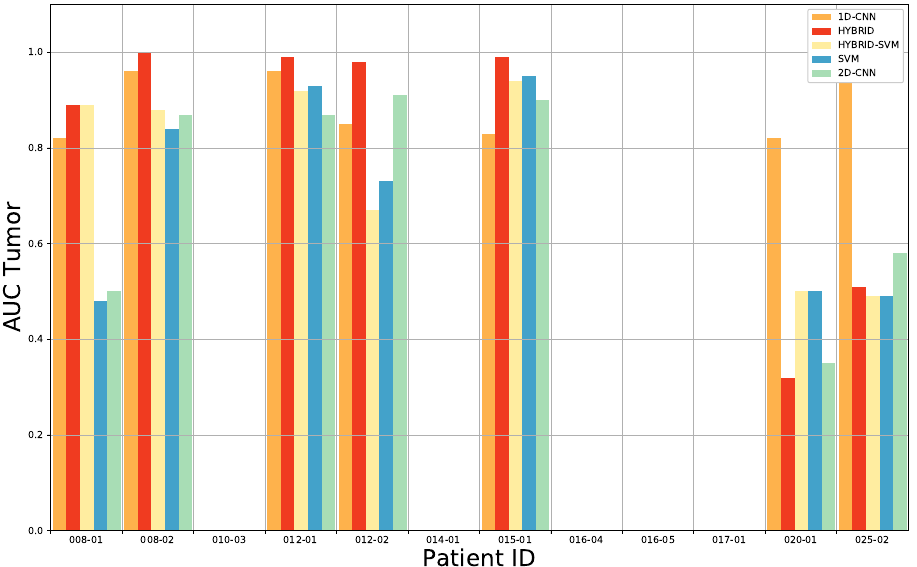
Figure 7. Average AUC results for the tumor tissue classification of the leave-one-patient-out cross-validation of the four-class classification for each method: 1D CNN, 3D–2D hybrid CNN, 3D–2D hybrid CNN + SVM, only SVM and the 2D